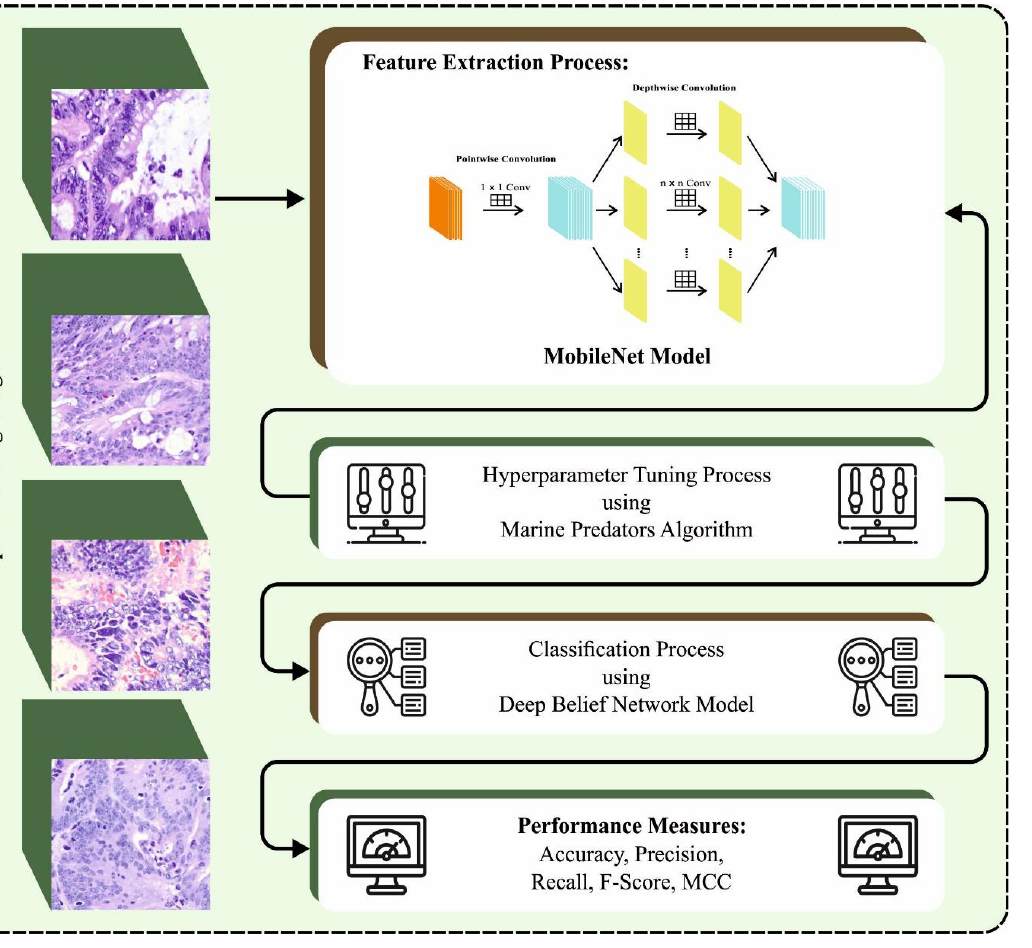
Figure 1. The overall flow of the MPADL-LC3 approach.